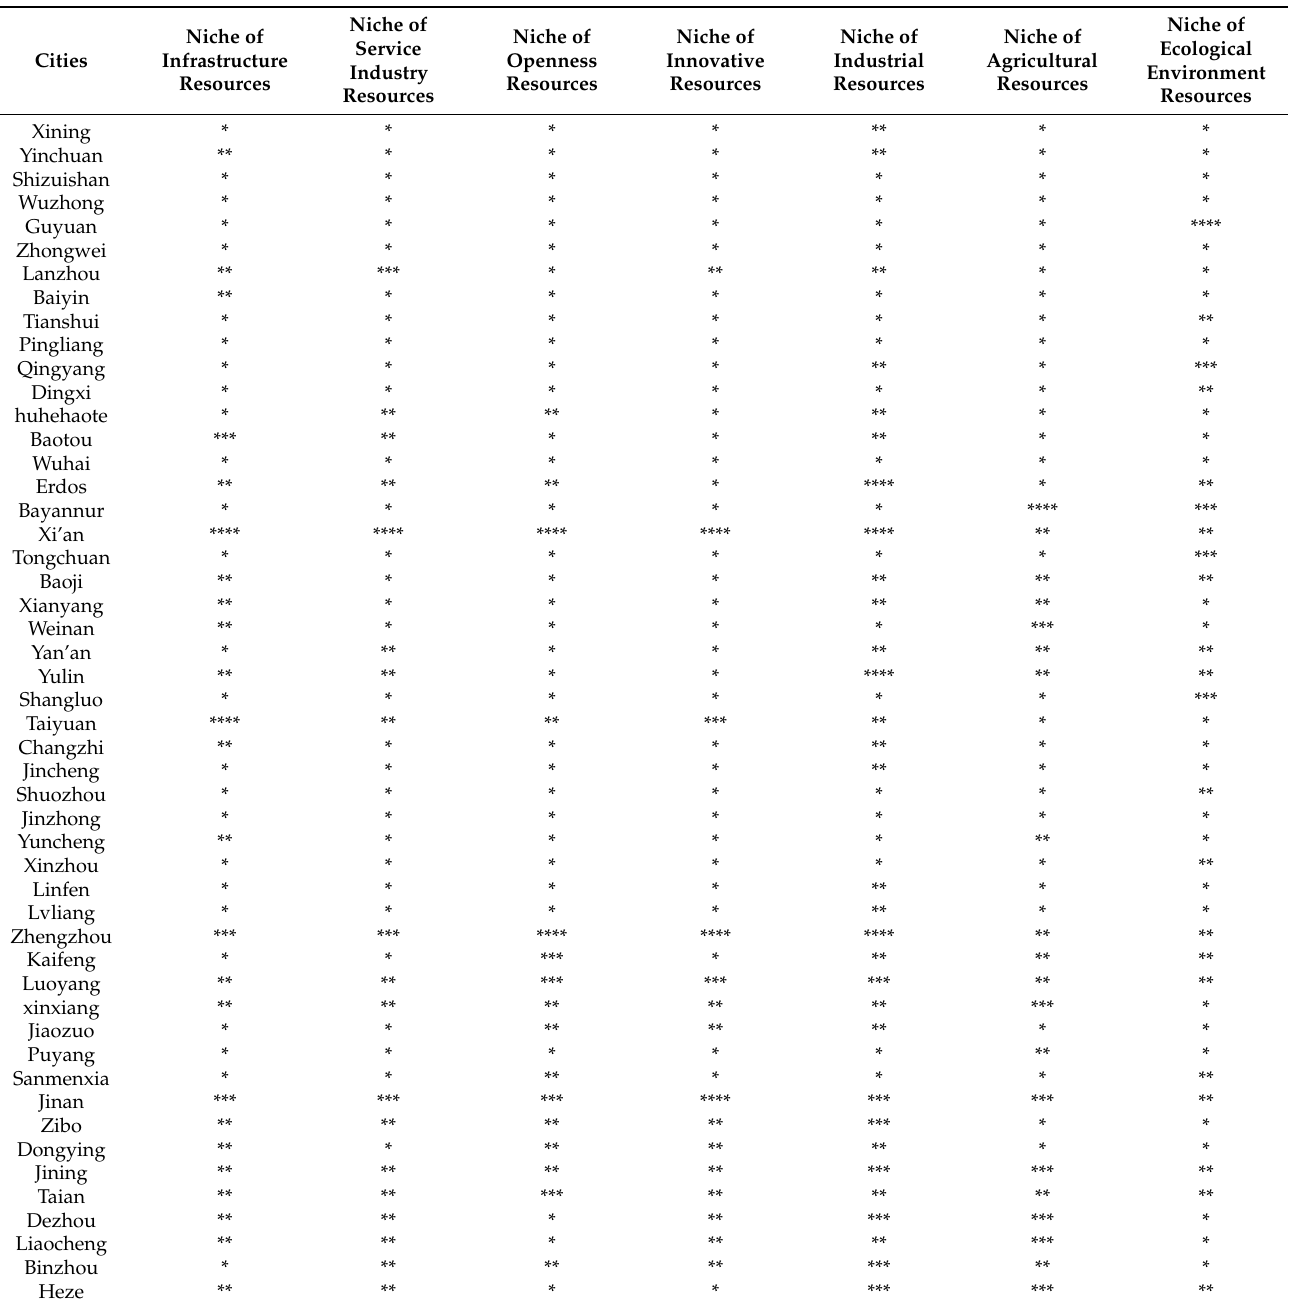
Table 3. Evaluation results of sub-dimensional niche suitability of the high-quality development in